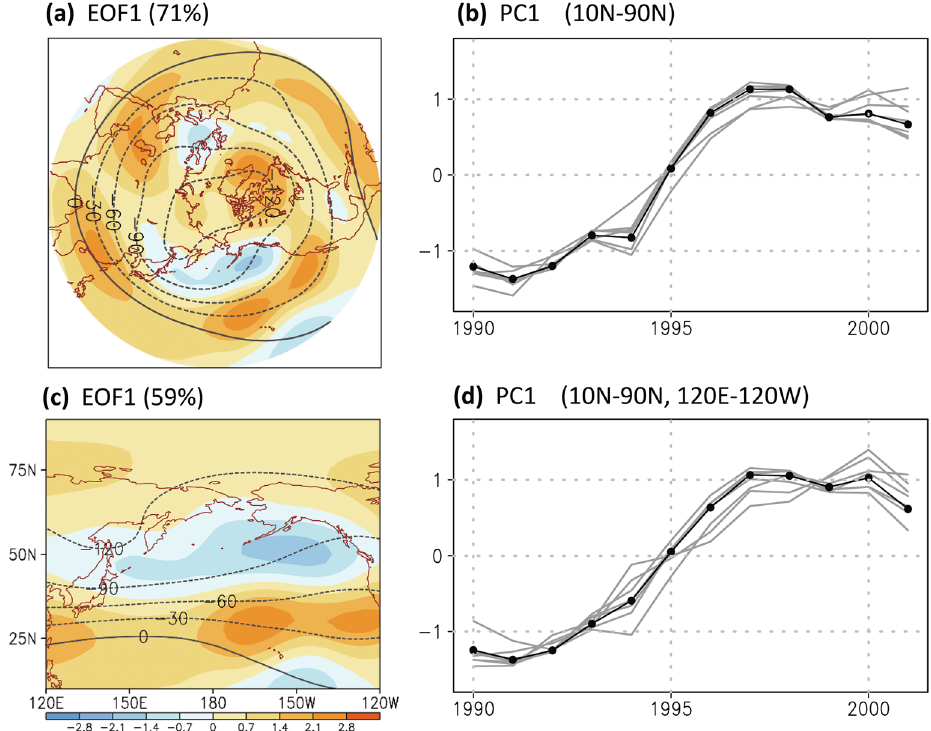
Figure 2. The first mode of empirical orthogonal function analysis (EOF1, shaded) of the 300-hPa streamfunction (unit: 10 6 m 2 s −1 ) of the reanalysis ensemble and the corresponding principle component (PC1, black line with dots) in December to February from 1987 to 2004 in the region at ( a – b ) 0°–360° E, 10° N–90° N and ( c – d ) 120° E–120° W, 10° N–90° N. A 7-year running mean is applied before calculating the EOF analysis. Contour denotes the averaged streamfunction (unit: 10 6 m 2 s −1 ) from 1990 to 1995. Gray lines denote the PC1s based on individual reanalysis data. The Figure was generated using software Grid Analysis and Display System (GrADS) Version 2.1.1.b0 (http:// cola. gmu. edu/ grads/ grads.